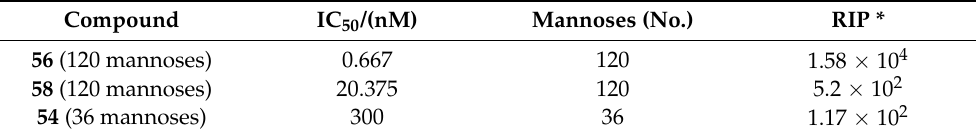
Figure 17. Structure diagram of glycofullerene ( 54 ). Adapted with permission from Ref. [78]. Copy- right 2013 American Chemical Society. Table 4. IC 50 and RIP values of different glycofullerene